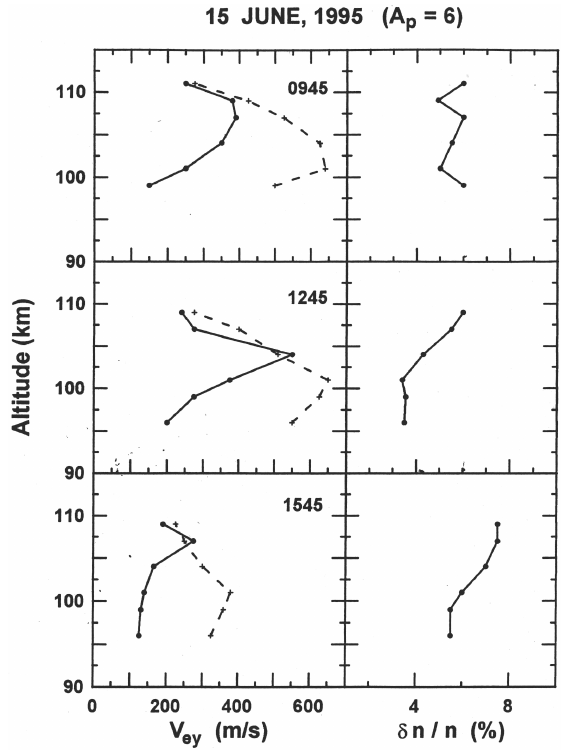
Fig. 3. Uncorrected (solid) and corrected (dashed) altitude profiles of V ey and δ n/n for the pre-noon, close to noon and afternoon on 15 June